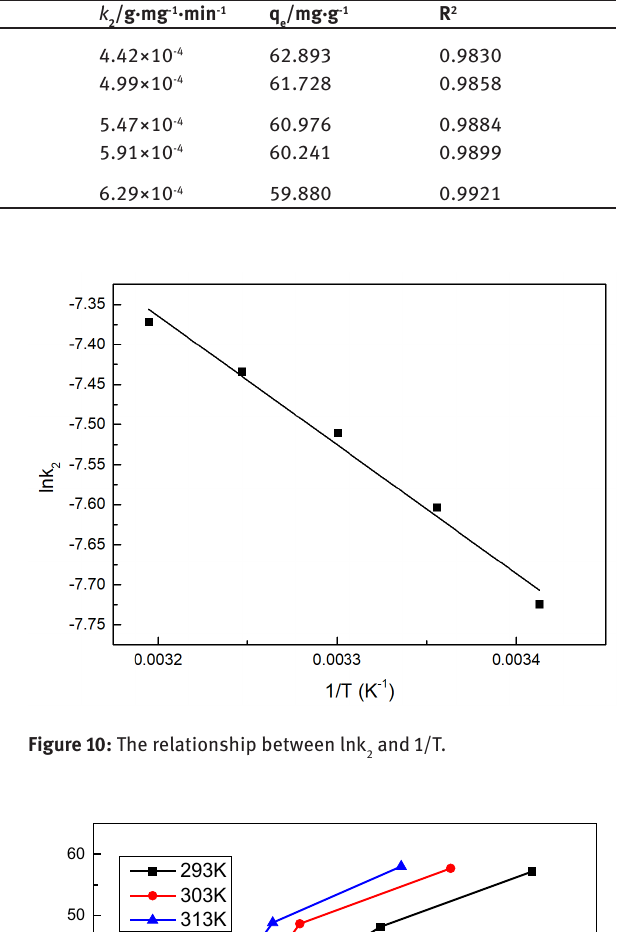
Table 2: Fitting results of kinetic models for Cu 2+ adsorption on the fermented Magnolia officinalis residues. T/K